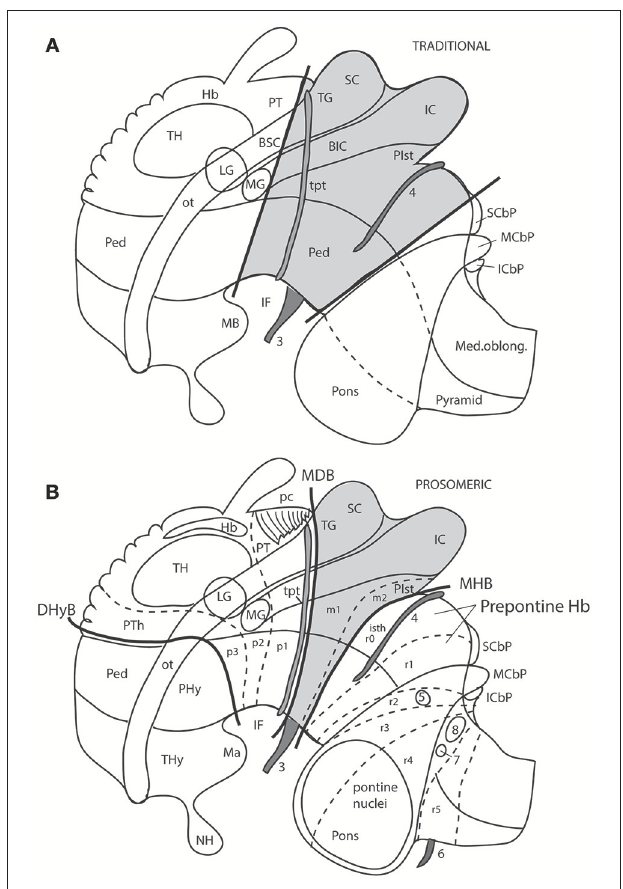
FIGURE 7 | Schemata from Puelles (2016) illustrating the different columnar and prosomeric models of the midbrain, in the context of neighboring diencephalic and hindbrain areas (no copyright permission required). Several superficial tracts were added for anatomic reference: the optic tract (ot), the cerebral peduncle and related medullary pyramid (Ped), the brachia of the superior and inferior colliculi (BSC, BIC), the transverse peduncular tract (tpt, related to the basal optic root), the extraneural oculomotor and trochlear cranial nerve roots (3, 4), and the middle (pontine) cerebellar peduncle (MCbP). (A) This drawing illustrates the conventional classic midbrain concept one finds in most textbooks, still abundantly used by clinicians. Thick straight black lines roughly indicate the rostral and caudal midbrain borders (the rostral limit being that suggested tentatively by His, 1893). It passes rostrally to the transverse peduncular tract (tpt; compare the position of this landmark in the caudal pretectum in B ). It also ascribes most of the interpeduncular fossa (IF) to the midbrain, when in fact this depression is largely diencephalic and rhombencephalic (compare in B ). The caudal midbrain boundary abuts the upper limit of the MCbP (see also the superior and inferior cerebellar peduncles; SCbP, ICbP; all of them in rhombomere 1, i.e., caudal to the isthmic segment). (B) This schema shows the more precise prosomeric concept relative to the same anatomic landmarks. I added with thin dash lines the borders between the diencephalic prosomeres (p1–p3) and the posterior commissure landmark (pc), important for placing the rostral mes-diencephalic boundary (MDB); this landmark jointly with the subcommissural organ characteristically mark the whole dorsal extent of the pretectum, though the crossed fibers converge laterally into a caudal subregion, the “commissural pretectum.” The transverse peduncular tract carrying retinal fibers of the basal optic root ascends peripherally to the peduncle just in front of the pretecto-mesencephalic border or MDB. This drawing does not depict the tectal gray formation that lies within the midbrain rostrally to the superior